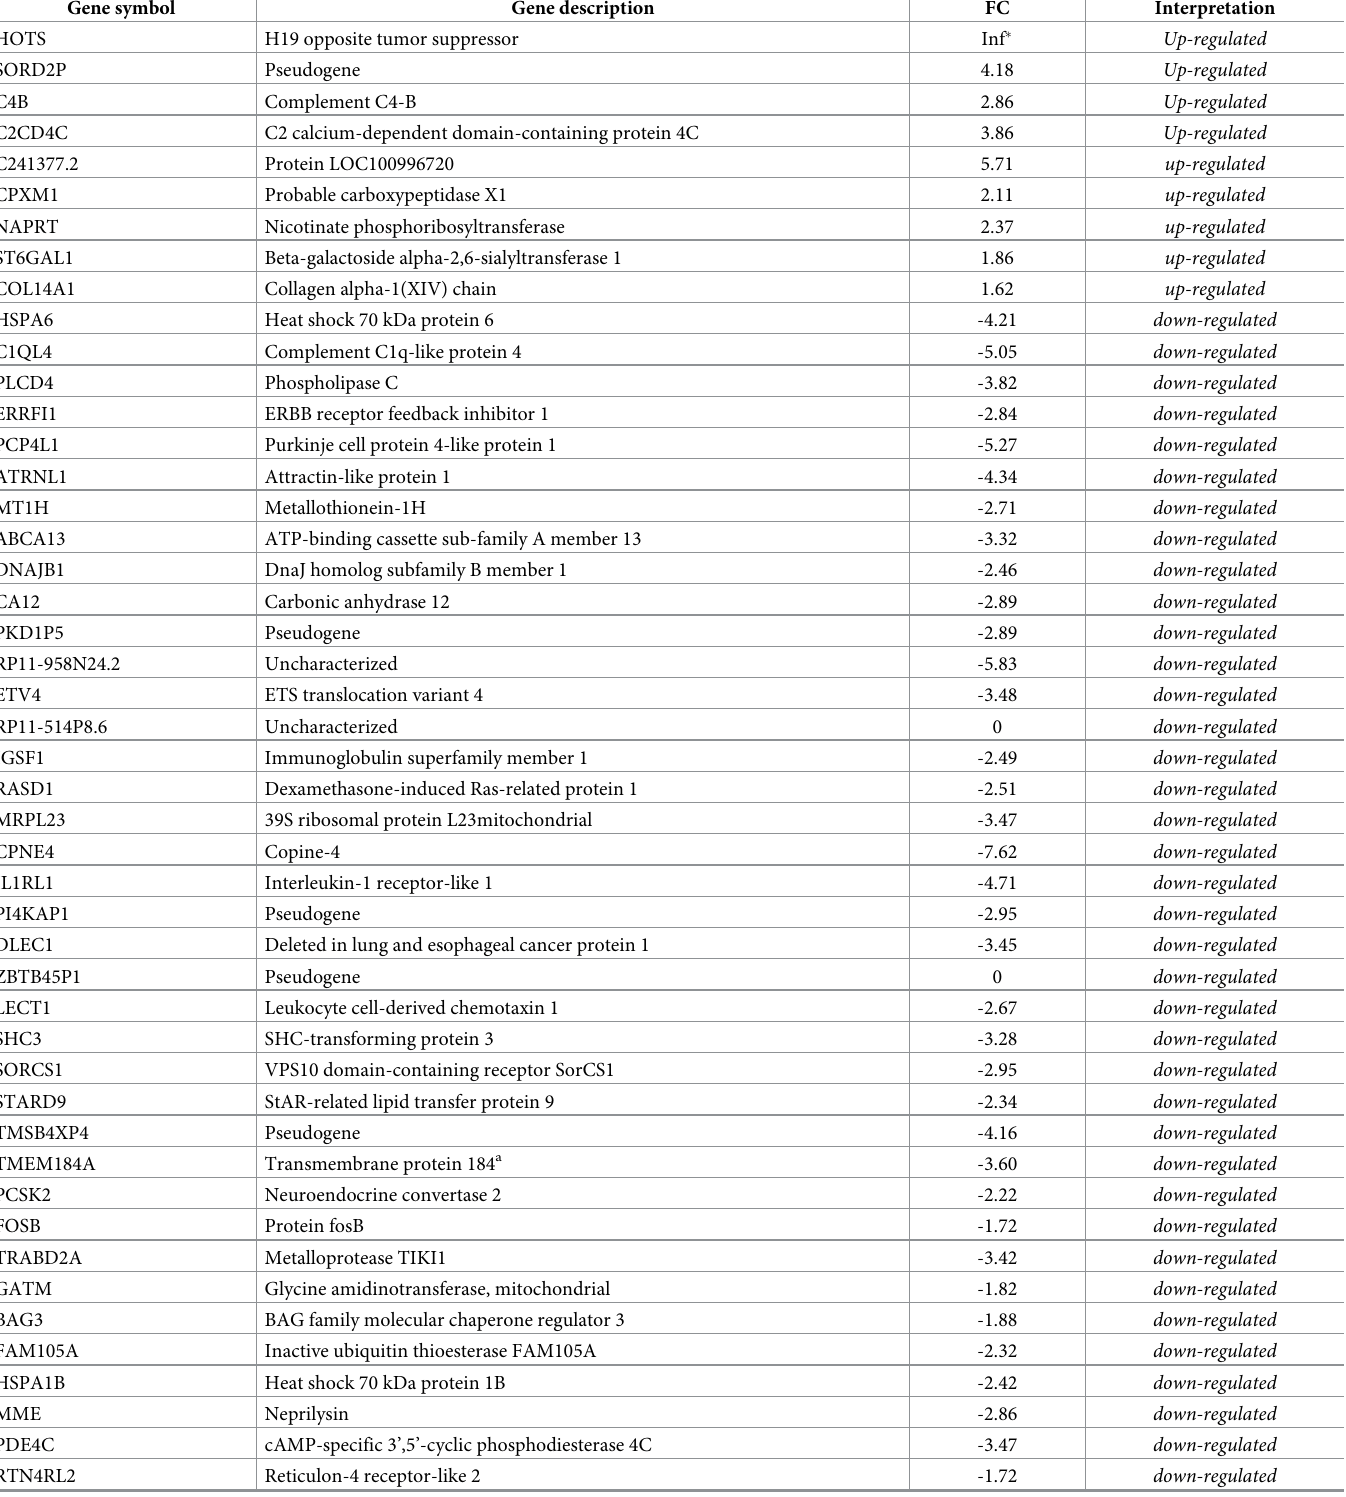
Table 1. List of genes differentially expressed in multinodular goiter and disease-free tissue when p < 0.05 (5%). Gene